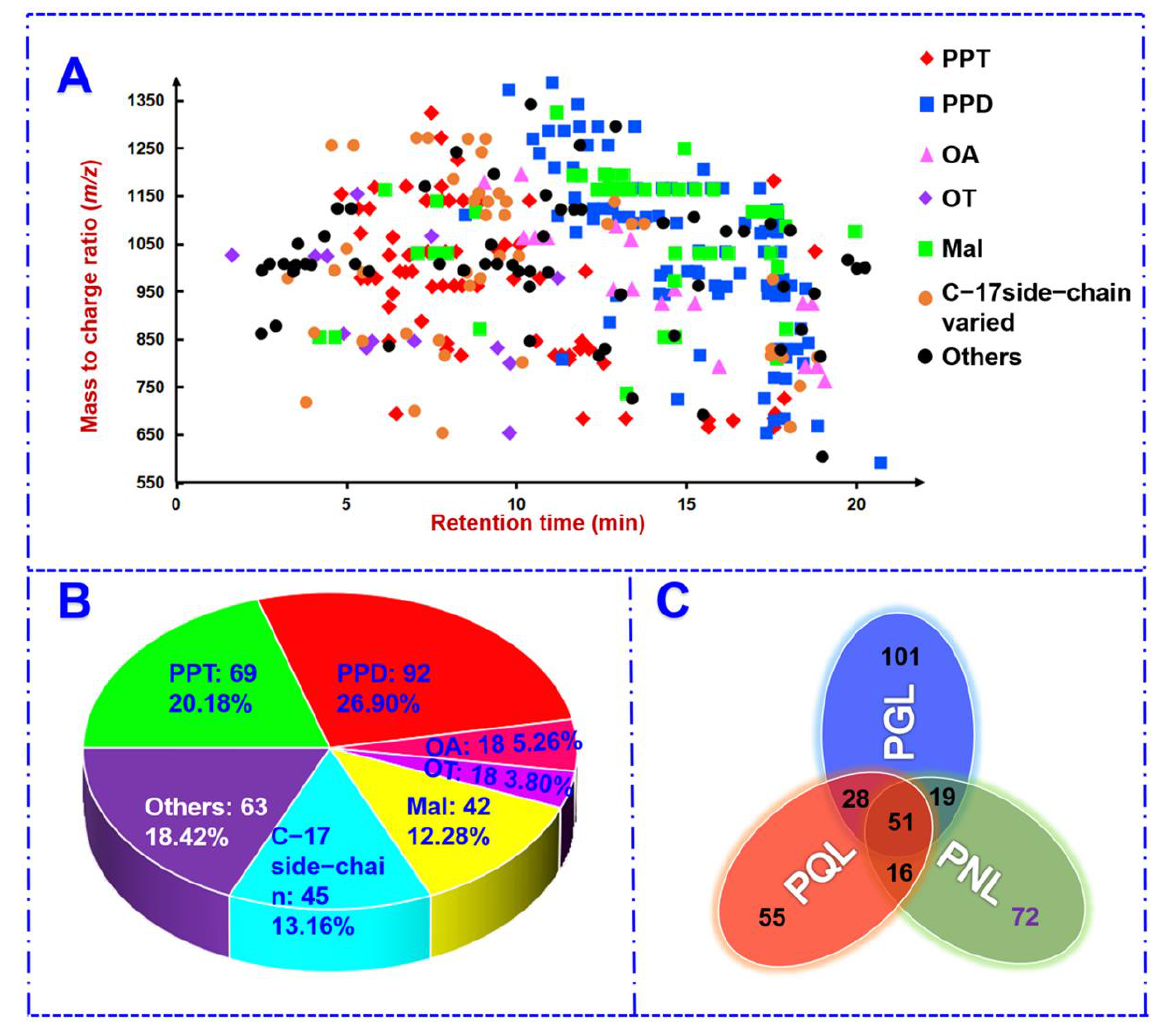
Figure 6. A global summary of the structural features of 342 ginsenosides characterized by PGL, PQL, and PNL. ( A ): A 2D scatter plot of all ginsenoside structures by t R and m / z ; ( B ): a pie chart sorted by the subcategory of ginsenosides; ( C ): a Venn diagram.